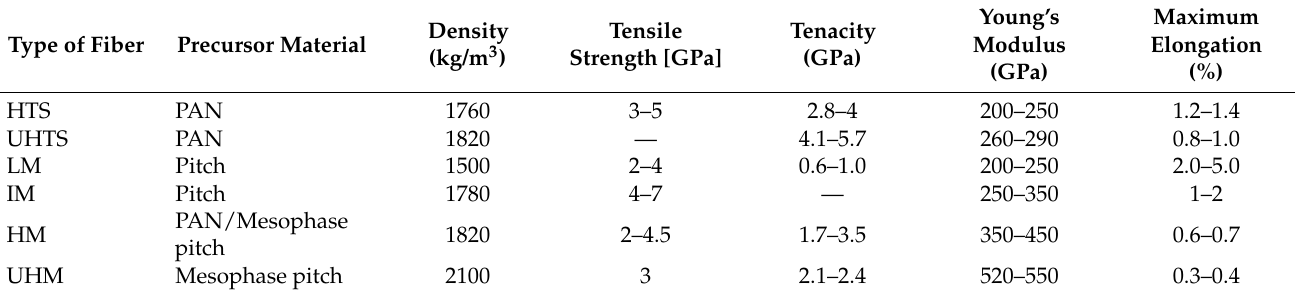
Table 7. Physical characteristics of various types of carbon fiber